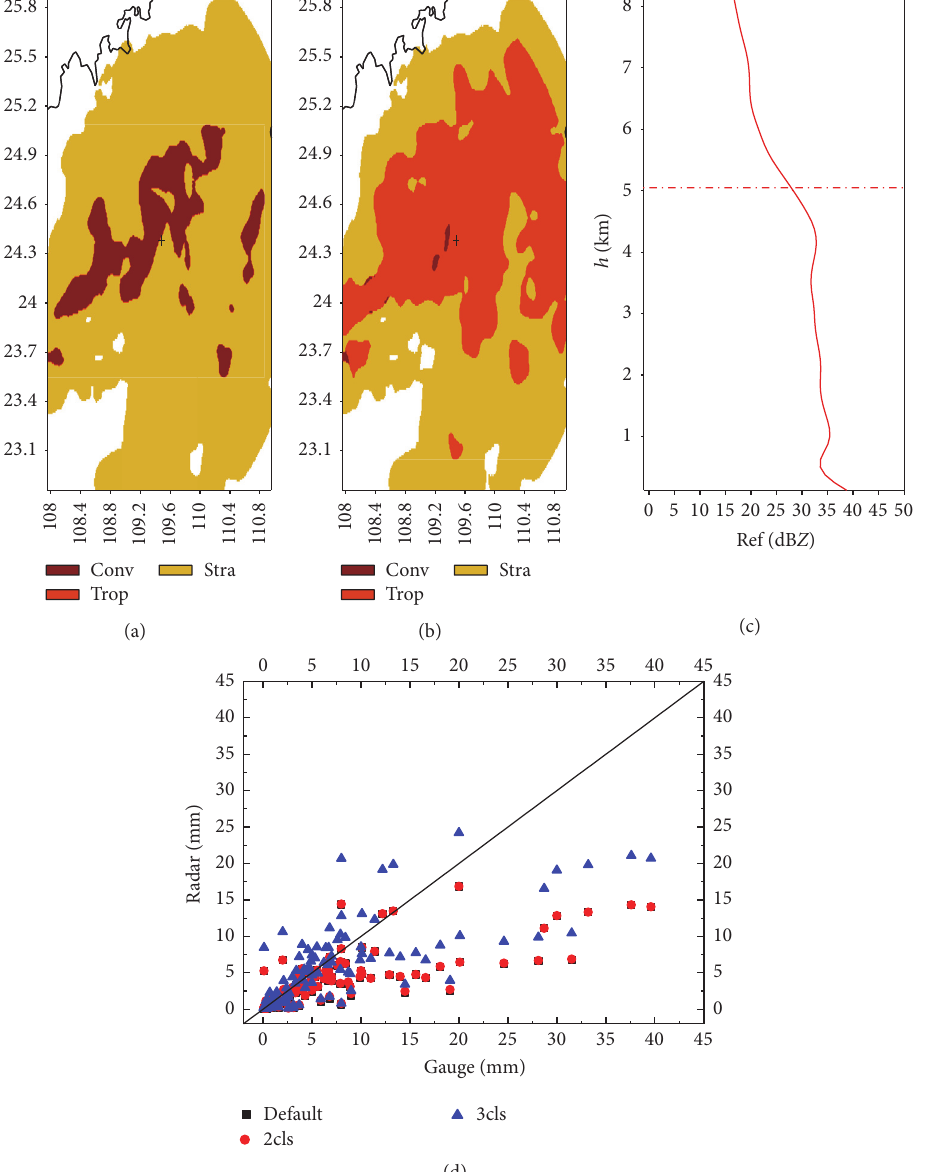
Figure 8: Heavy rainfall in Liuzhou during June 11-12, 2008, as recorded at (or analyzed for) 1300 UTC on June 12: (a) results of the FL algorithm (the abscissas represent longitude, the vertical axis represents latitude, the “+” sign represents the radar location, and colors of “Conv” and “Stra” represent convective and stratiform rainfall, resp.). (b) Distribution of convective, stratiform, and tropical rainfall. (c) Averaged stratiform VPR (the abscissas represent the value of reflectivity in dB Z , the vertical axis represents the altitude in km, the long dashed line is the 0 ∘ C isotherm altitude, the red solid line is the VPR before bright band correction. (d) Scatter plot of gauge versus radar- derived 1-h accumulated precipitation (the abscissas represent gauge results in mm, the vertical axis represents radar-derived 1-h accumulated precipitation in mm, and the diagonal line represents the ideal